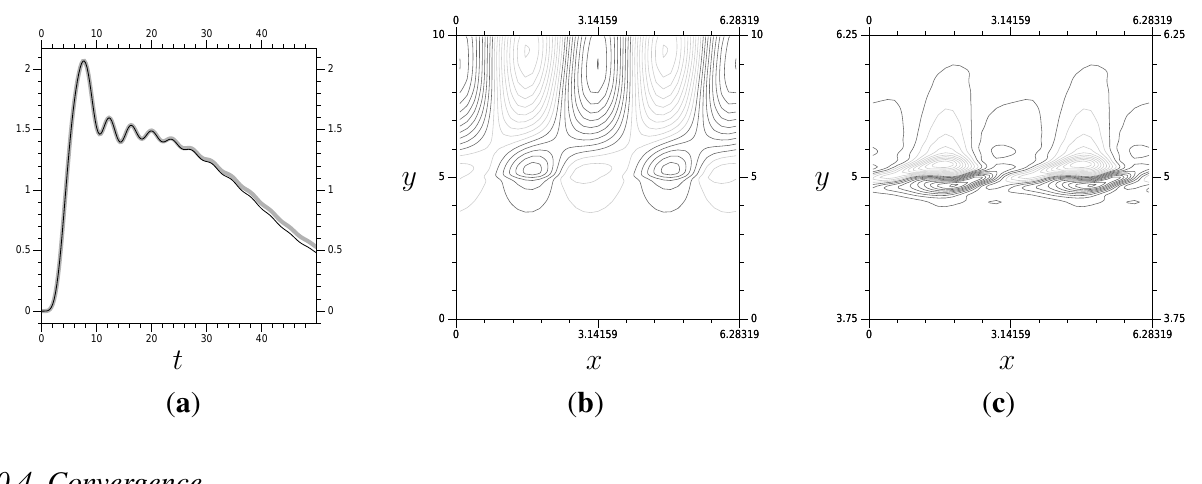
: V − Figure 16. Plots for V − multi-scale models of the ϵ = 0 . 01 Rossby wave problem. 3 4 All use Λ = (1 . 5 , 6 . 5) . The flux is plotted against that for the V − control results (the lighter, 4 thicker line). The results using the larger Λ = (3 . 5 , 9 . 0) and Λ = (3 . 5 , 9 . 5) are omitted, as they are visually identical to the full V − control results from Figure 15. ( a ) F ( t ) ; ( b ) P at 4 t = 50 ; ( c ) Z at t = 50